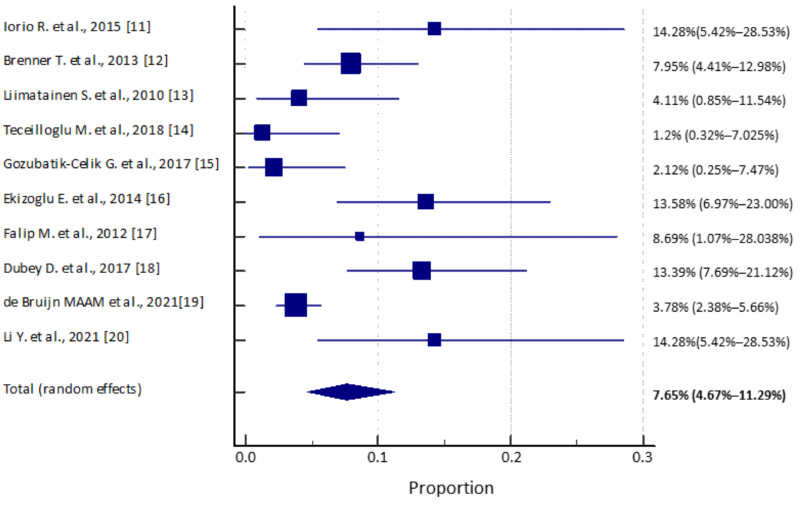
Figure 2. Pooled prevalence forest plot